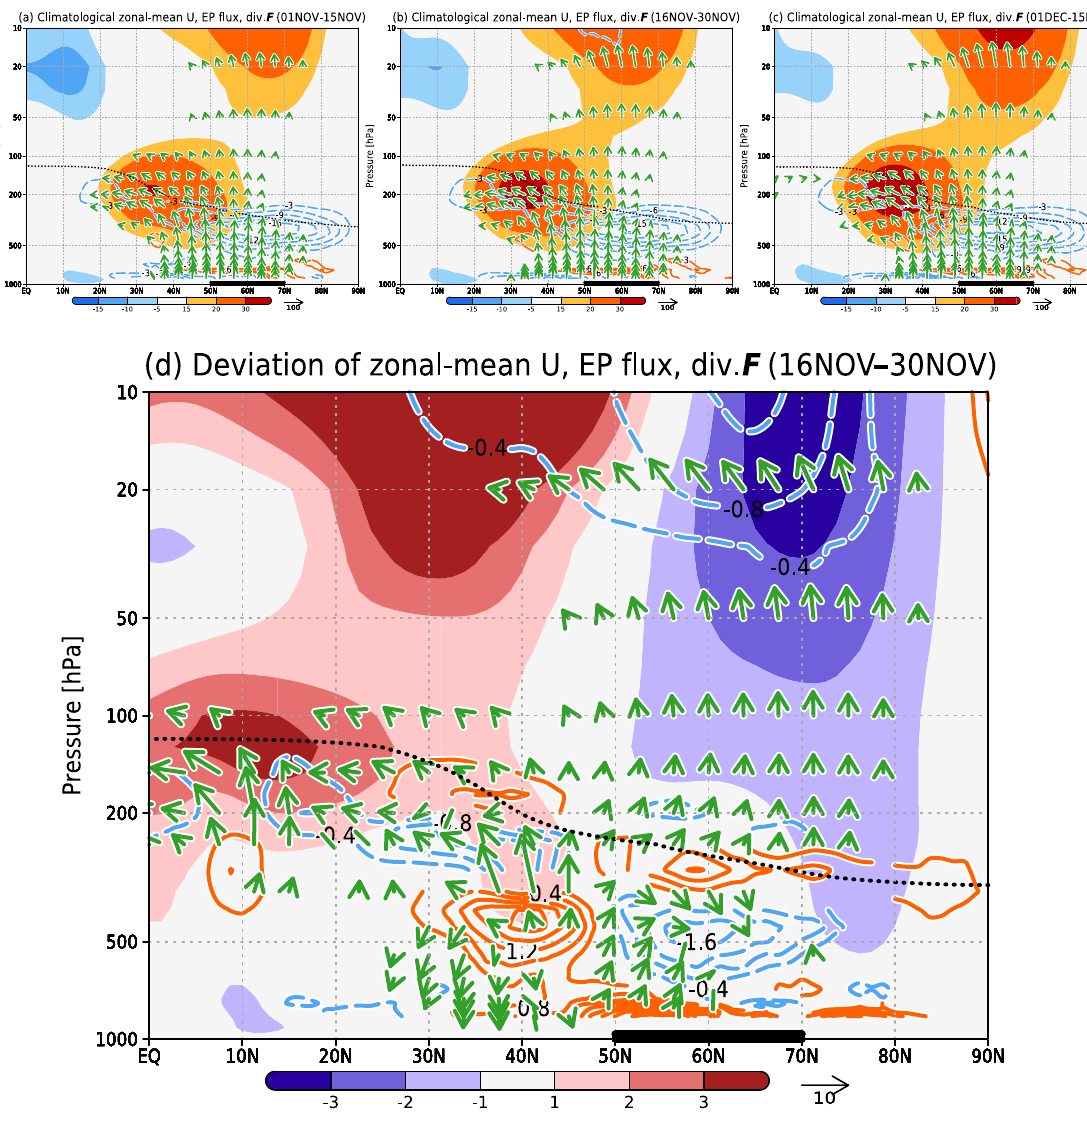
Figure D1. Climatological zonal-mean zonal wind speed (ms − 1 , color shading), EP flux (m 2 s − 2 , vectors), and the flux divergence (ms − 1 day − 1 , contours) during (a) early November (1–15 November), (b) late November (16–30 November), and (c) early December (1–15 December). (d) Late November deviations from the expected sinusoidal regression expression calculated with Eq. 4 (see Sect. 3.3). The EP flux is standardized by density (1.225kgm − 3 ) and the radius of the Earth (6 . 37 × 10 6 m). The vertical component of the vectors is multiplied by a factor of 250. The bold black line indicates the longitudinal range for Siberia (50–70 ◦ N). The black dashed line indicates the tropopause height during these periods defined by WMO (1957). The definition is the lowest height at which the temperature lapse rate decreases to 2Kkm − 1 or less and remains below this value for a depth of at least